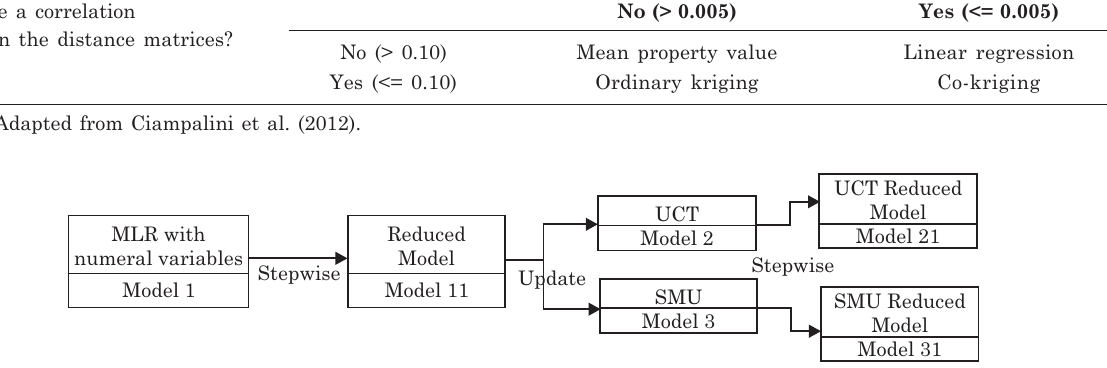
Figure 2. Flowchart with strategic steps to evaluate the performance of linear regression (MLR) with categorical covariates land use (UCT) and soil map units